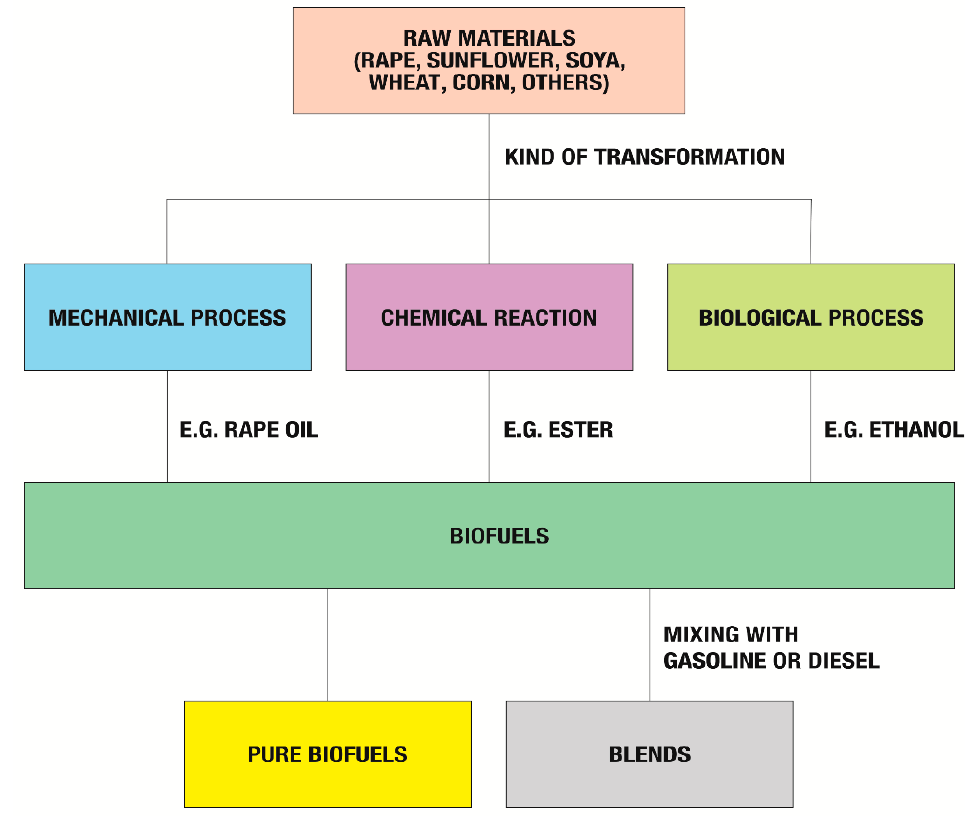
Figure 5. Processes for producing biofuels in Poland.